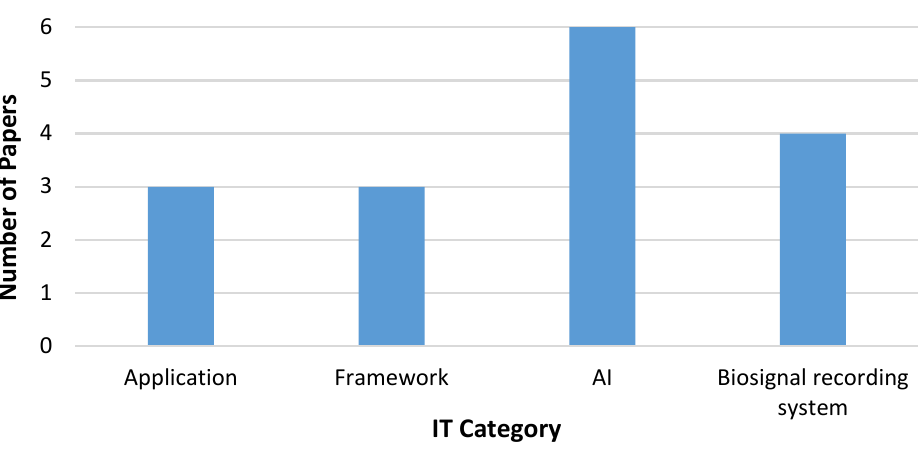
Figure 8. The number of studies and the IT used.